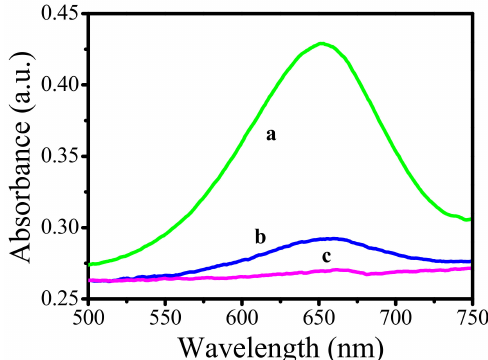
Figure 5. Absorption spectra of TMB system in the absence of L-ascorbic acid (AA) and presence of AA. ( a ) 0.8 mL 5, 5 (cid:48) -tetramethylbenzidine (TMB) + 0.2 mL Au-tipped Pt NRs + 0.3 mL H 2 O 2 for 5 min, ( b ) 0.8 mL TMB + 0.1 mL Au-tipped Pt NRs + 0.3 mL H 2 O 2 for 5 min, ( c ) 0.8 mL TMB + 0.2 mL Au-tipped Pt NRs + 0.3 mL H 2 O 2 + 0.2 mL AA for 5 min. The concentration of AA was 1 µ